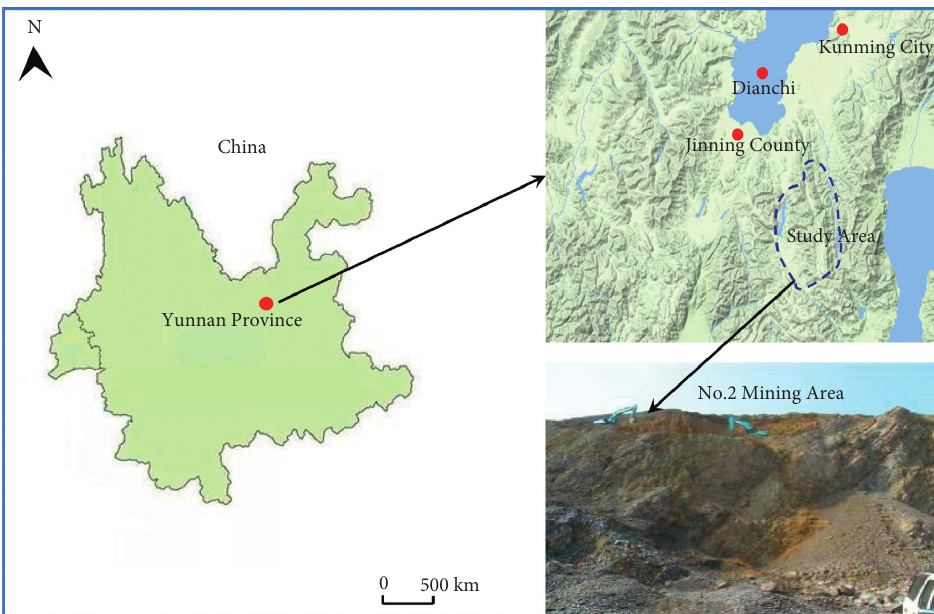
Figure 1: Geographical map of no. 2 mining area of Jinning Phosphate Mine.